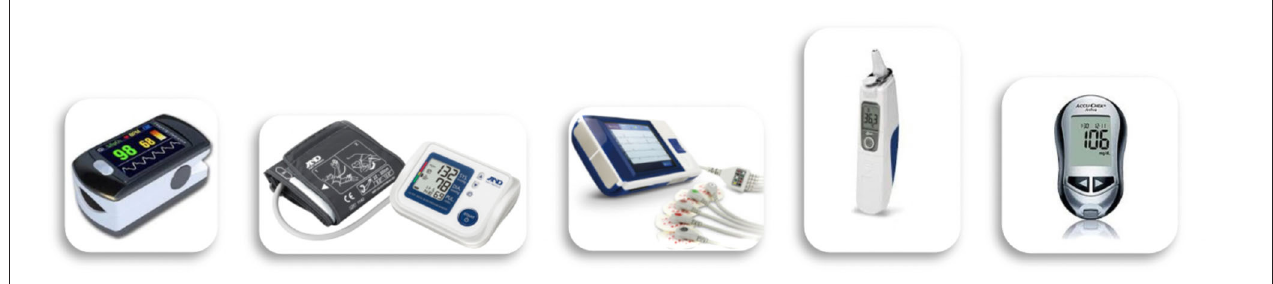
FIGURE 2 | Medical devices included in the telehealth service for assessing physiological measures of patients